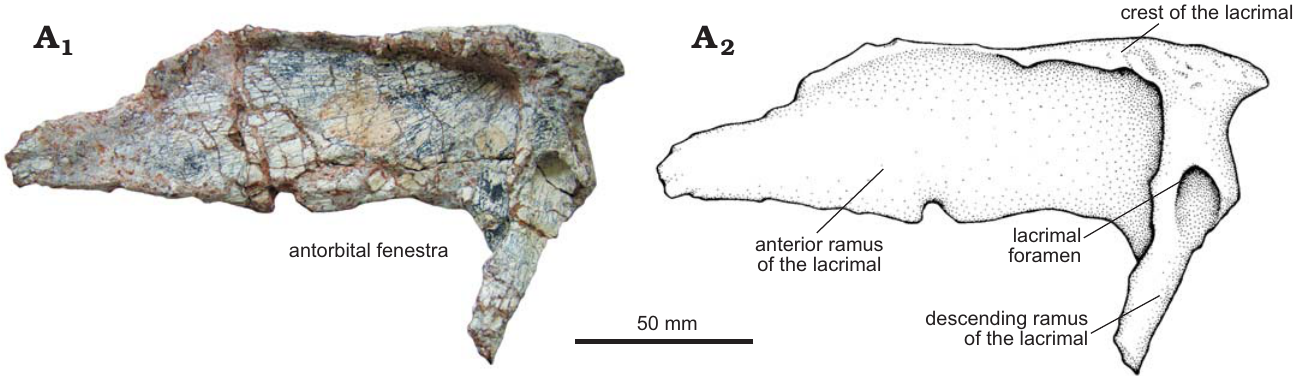
Fig. 8. The pseudosuchian archosaur Prestosuchus chiniquensis Huene, 1938 (UFRGS-PV-0629-T) from the Dinodontosaurus Assemblage Zone, Ladinian, Middle Triassic, Dona Francisca municipality, Rio Grande do Sul State, Brazil; left lacrimal in lateral view. Photograph (A 1 ) and explanatory drawing (A 2